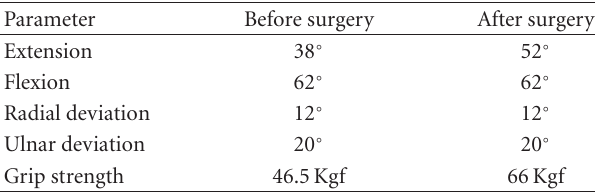
Table 1: Range of motion and grip strength on the right wrist and hand before and after treatment. Parameter